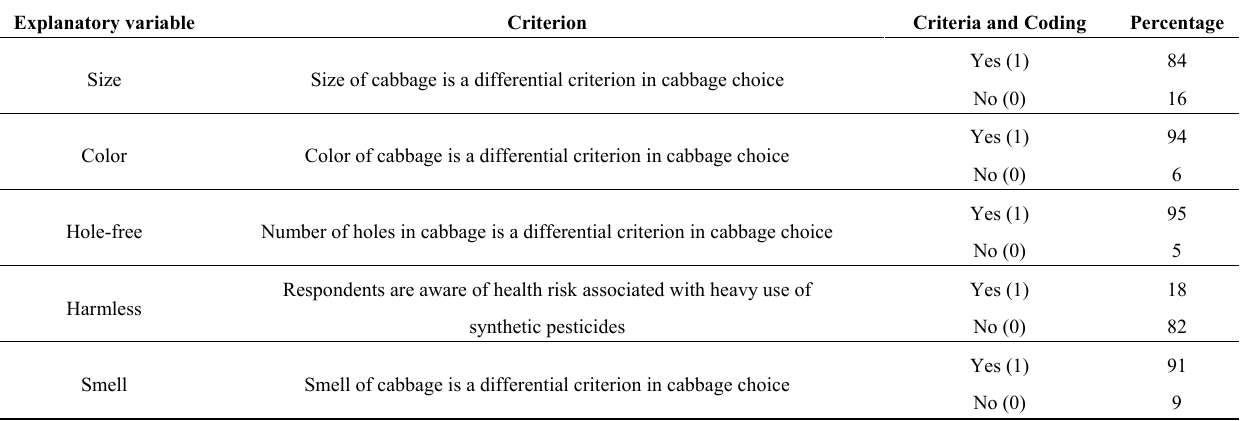
Table 2. Cabbage attributes influencing consumer purchase decisions (N =